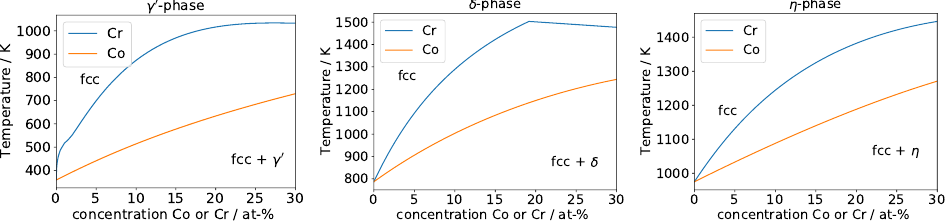
Figure 5. Pseudobinary phase diagrams showing the solvus lines of the phases γ (cid:48) , δ , η as a function of the Cr or Co content. The alloy composition at 0% is Ni5at-%Al for γ (cid:48) , Ni8at-%Nb for δ and Ni8at-%Ti for η . The kink in the line for the δ -phase is due to the solvus line meeting the solidus